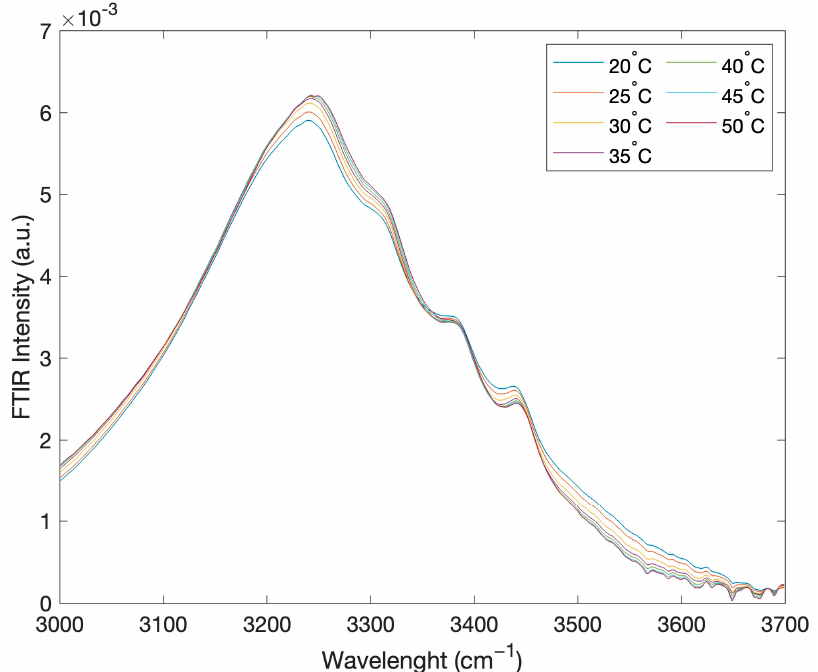
Figure 2. FTIR intramolecular OH stretching band intensity for the concentration value of 90% glucose and 10% water, as a function of temperature.